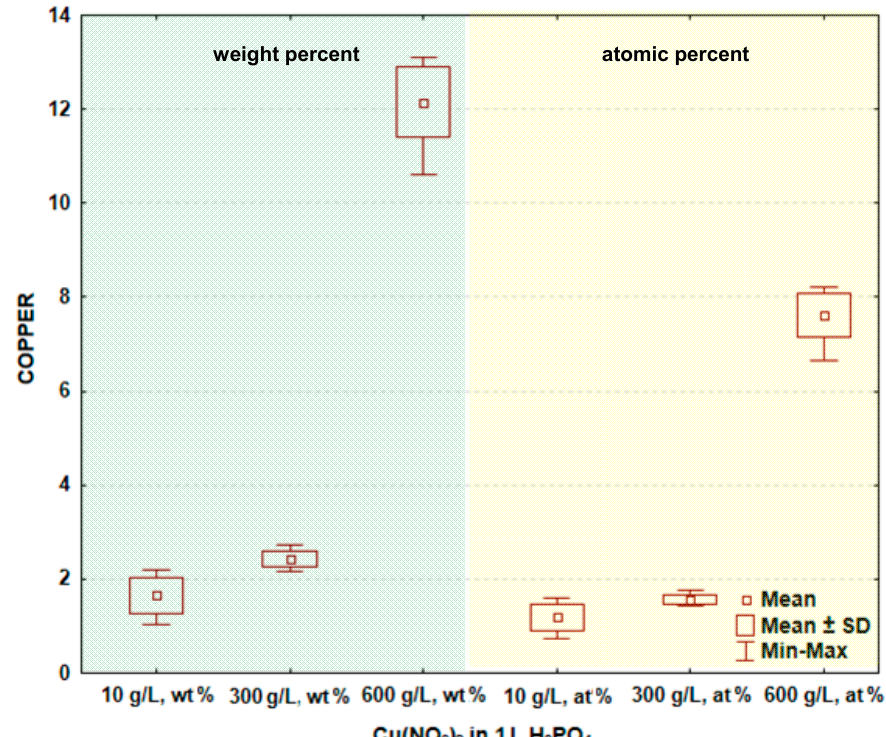
Figure 2. Box and whisker plots of the amount of copper in the surface layer formed on titanium after PEO. SD: Standard deviation.